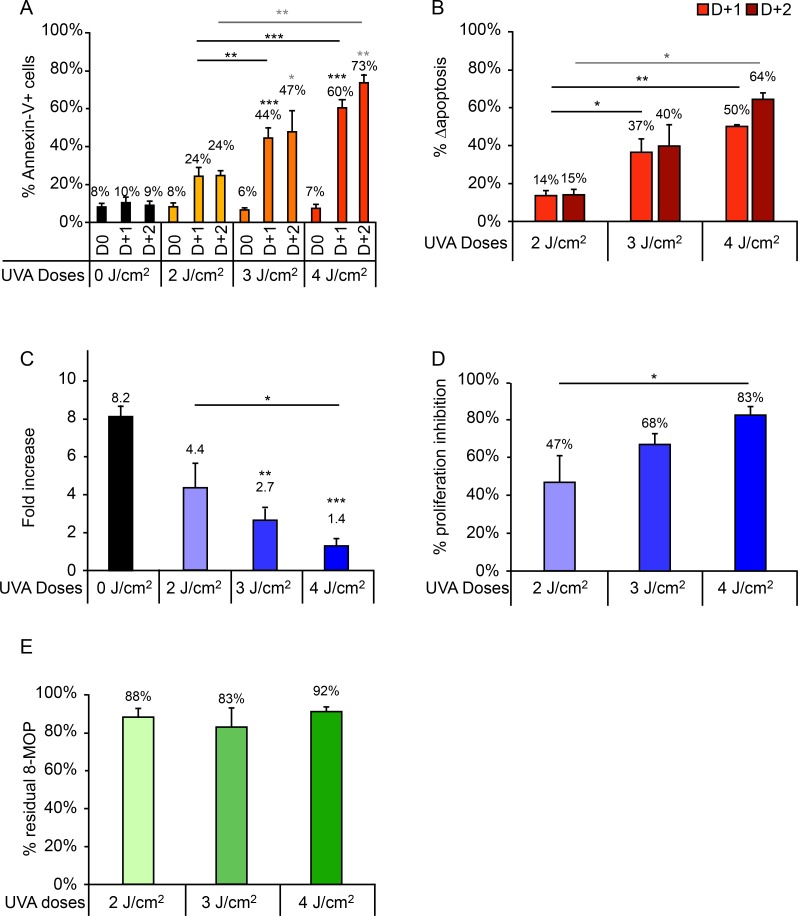
Impact of UVA dose (2 J/cm2, 3 J/cm2, and 4 J/cm2) on cellular response of samples treated with 4% HCT in the irradiation bag.(A) Percentage of Annexin-V+ cells measured daily up to 2 days after irradiation. (B) Δapoptosis determined on days 1 and 2 post-irradiation. (C) Fold increase on day 3 post-irradiation relative to day 0. (D) Proliferation inhibition percentage, calculated as the percentage decrease in proliferation in irradiated versus control samples. A pairwise comparison of each treatment condition was performed. For clarity, only statistically significant results are shown: *p<0.05; **p<0.01; ***p<0.001. Significant differences with respect to the control (UVA -) are indicated with an asterisk above the relevant bar, while comparisons between irradiated samples are indicated with an asterisk over a line linking the relevant bars. For Annexin-V+ cells (A) and Δapoptosis (B), comparisons performed on days 1 and 2 post-irradiation are indicated in black and gray, respectively.